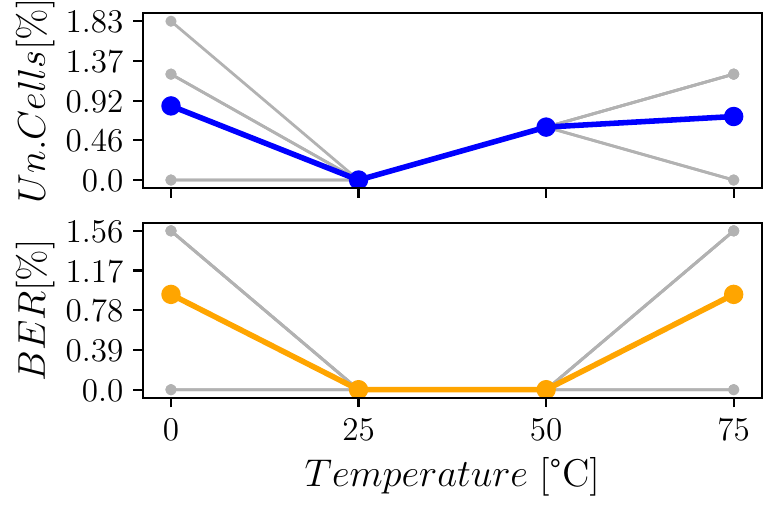
Figure 10. Unstable Cells and BER in percentage under temperature variations over 5 chips, average trend highlighted in blue color.